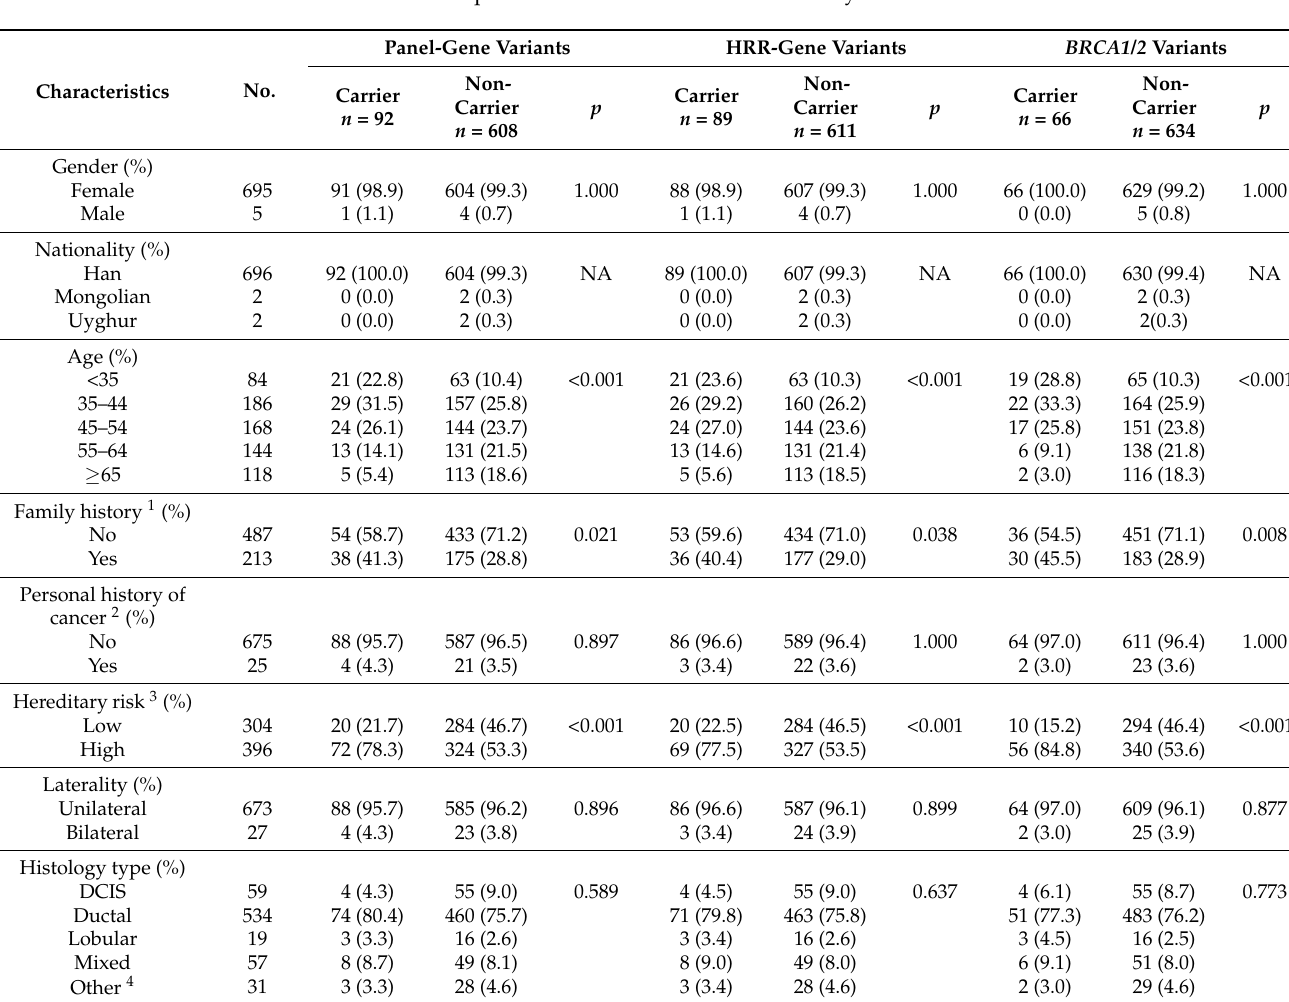
Table 3. The association between deleterious germline variants and clinicopathological characteristics in 700 Chinese patients with BC included in the